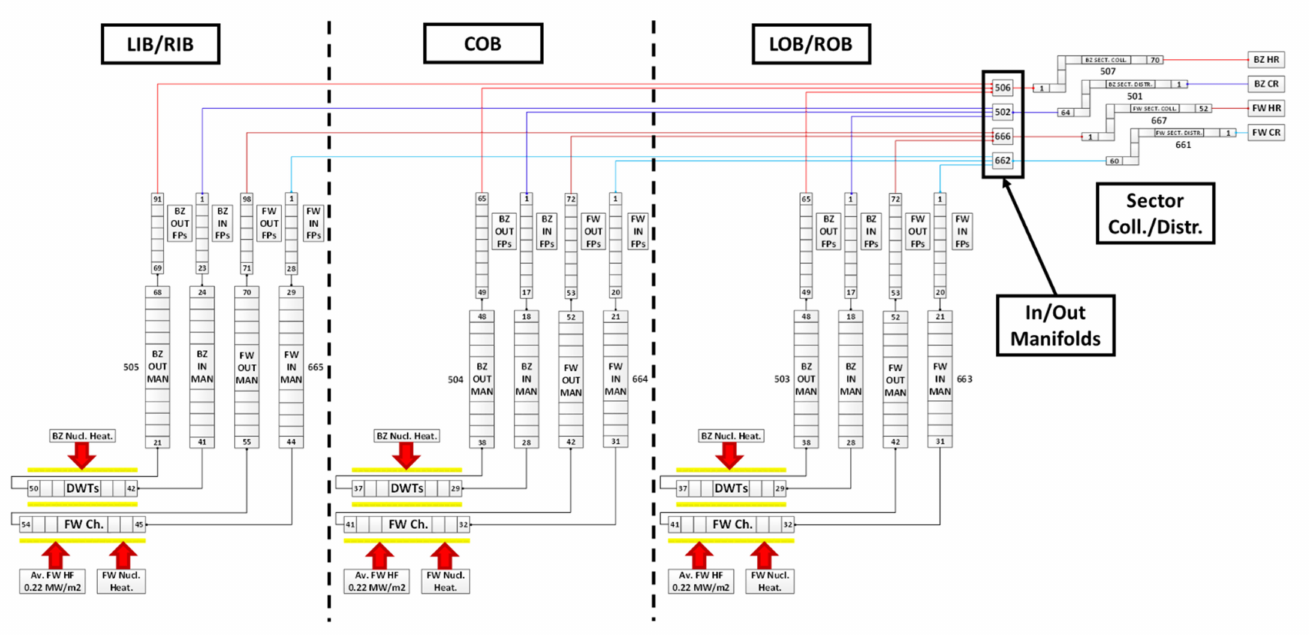
Figure 3. Schematic view of the blanket model, sector one of sixteen. All the Breeder Zone (BZ) and First Wall (FW) Primary Heat Transfer Systems (PHTS) in-vessel components are represented. In addition, red arrows indicate the power source